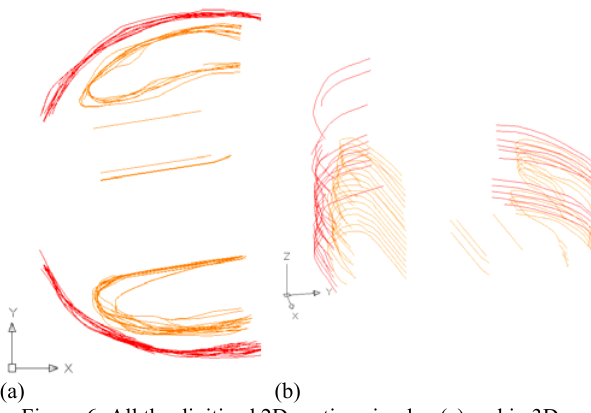
Figure 9: 3D visualization of the prospection findings